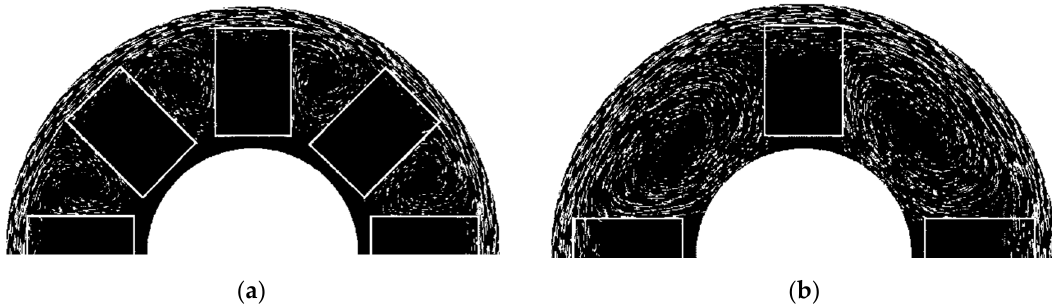
Figure 5. Structure of the metal flow on the cross-section of auto catalyst carriers for different numbers of catalyst in the channel: ( a ) 8; ( b ) 4. (Current intensity—20 A, frequency—50 Hz).